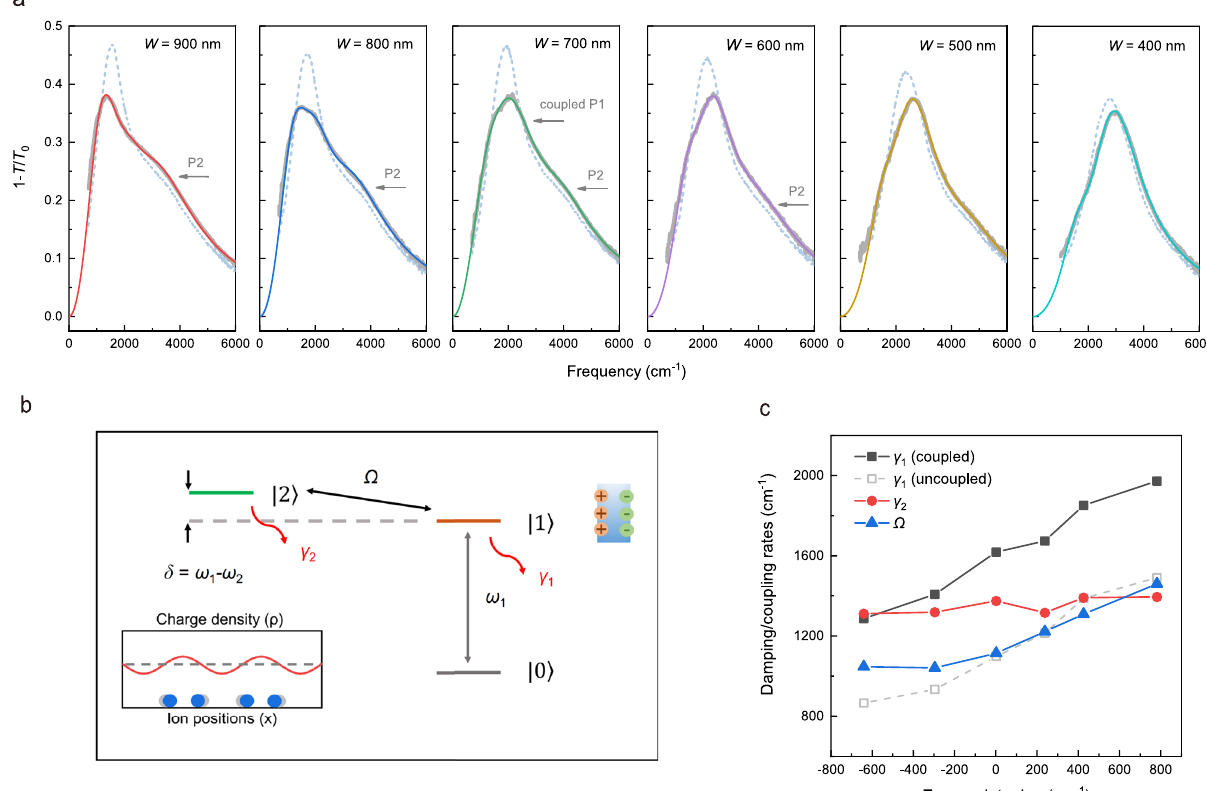
Fig. 5 The coupling between plasmonic and CDW excitations in 2H-TaSe 2 . a The extinction spectra of TaSe 2 plasmons with ribbon width of 900 – 400 nm. The blue dashed and the gray solid lines correspond to the measured spectra at 120 and 15 K, respectively. The colored lines represent the fi tted spectra at 15 K by the coupled-oscillator model. P1 and P2 denote the fi rst-order and the second-order plasmons, respectively. b A sketch for the coupling effect in a prototype three-level system. The gray, orange, and green solid lines illustrate the energy level of the ground state 0 j i , the bright excited state 1 j i , and the dark state 2 j i , respectively. The gray arrow denotes transition 1 ( 0 j i ! 1 j i ) with frequency of ω 1 . The gray dashed line is plotted to de fi ne the energy detuning δ ¼ ω 1 (cid:2) ω 2 , where ω 2 is the transition frequency between state 2 j i and 0 j i . The red arrows near the state 1 j i and 2 j i represent the damping rates of the corresponding transitions, which are γ 1 and γ 2 , respectively. The black arrow de fi nes the coupling rate Ω between state 1 j i and 2 j i . The left inset illustrates the modulation of charge density ( ρ ) and ion positions ( x ) in the CDW phase. The right inset denotes the positive (orange circle) and negative charge (green circle) in the ribbon when the localized plasmon is excited. c The fi tted damping/coupling rates as a function of energy detuning (the unit is wave number) at 15 K. The uncoupled plasmon damping rate γ 1 is estimated by the extrapolation from the temperature evolution of the plasmon peak width above T C1 , which generally follows linear relations (see Supplementary Fig.